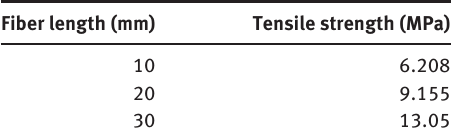
Table 2 Effect of fiber length on tensile property of untreated coir fiber-reinforced epoxy composite.